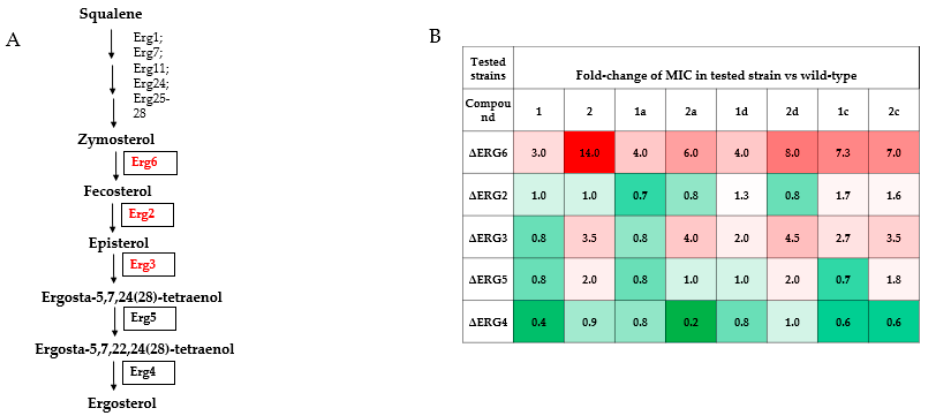
Figure 7. Susceptibility of ergosterol-pathway mutants to parent and derived antibiotics. Schematic of the ergosterol biosynthesis pathway ( A ) with genes implicated in clinical polyene resistance highlighted in red ([52] for Erg6, [53,54] for Erg2, [55] for Erg3) and tested genes in boxes. ( B ) Table of fold-changes in MIC of different strains, normalized to the MIC of the wild type strain of each compound. Each experiment was repeated no less than 3 times and the average result is presented.